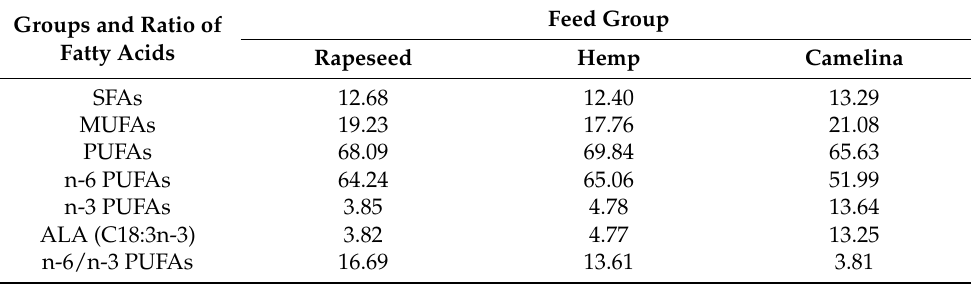
Table 2. The proportions (%) of main fatty acid groups and their ratio in the fat of quail feed. Feed Group Groups and Ratio of Fatty Acids Rapeseed Hemp Camelina SFAs 12.68 MUFAs